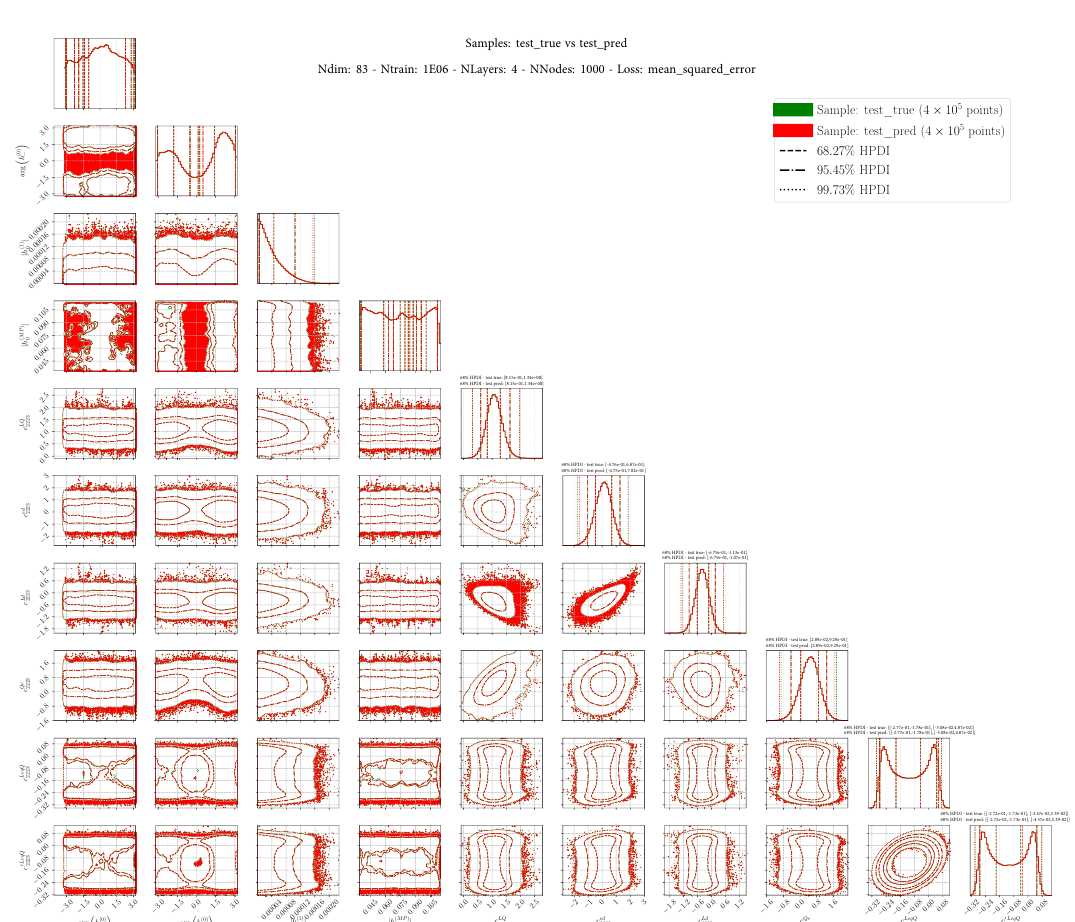
Figure 12: 1D and 2D marginal probability distributions for the six parameters of interest and for four selected nuisance parameters from the DNNLikelihood global + (cid:96) − fit of b → s (cid:96) transitions from Ref. [ 154 ] . For the parameters of interest the 68% Highest Probability Density Interval (HPDI) is reported on top of the 1D